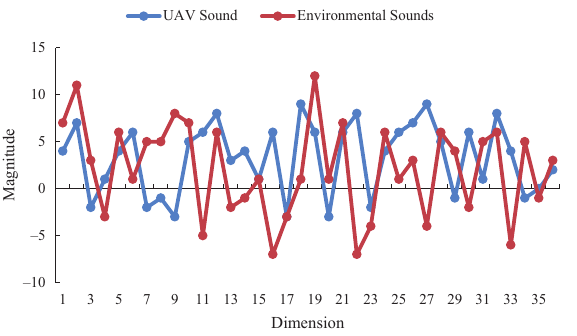
Figure 1. Comparison of MFCC characteristics between two kinds of samples